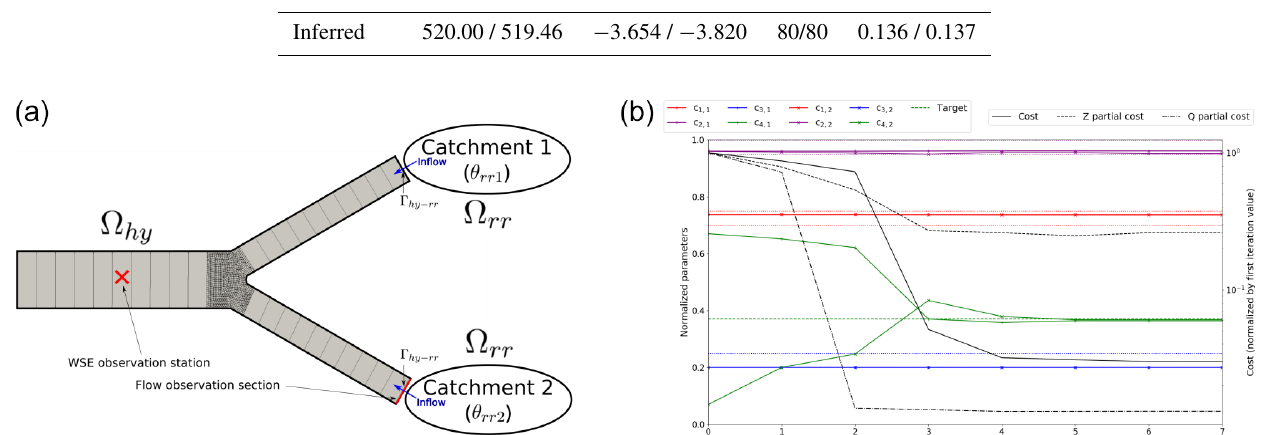
Figure 11. Simultaneous inference of GR4H hydrological parameters in two catchments from multi-source observations: WS elevation and flow observations. (a) Multi-D hydraulic mesh and modeled hydrological catchments. Hydrological discharge at the outlet of (cid:127) rr flows in upstream in (cid:127) hy . Observation stations (red cross and red line) are used for inferring hydrological parameters. (b) Inference of two sets of four hydrological parameters: normalized costs and parameter values over the course of the iterative optimum search. The x 4 background values are erroneous. x 1 , x 2 and x 4 background values are set to target